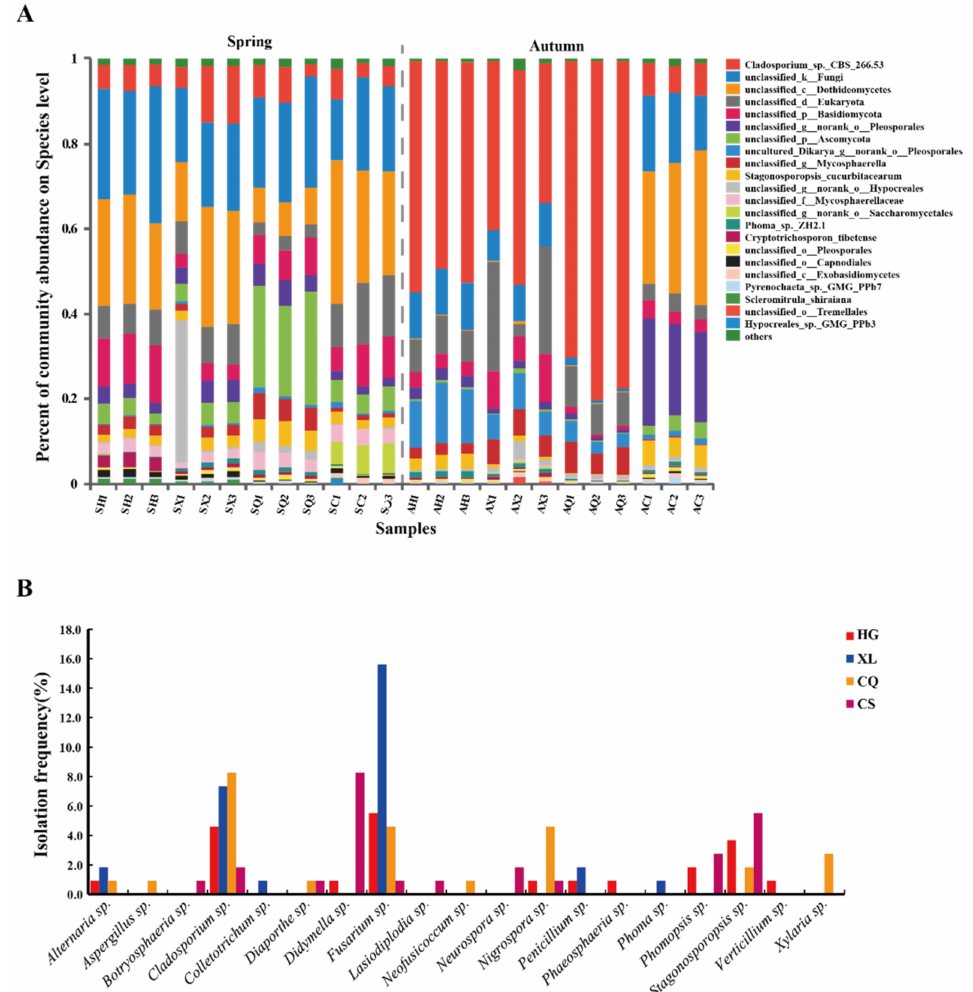
Figure 7. Taxonomic distribution and comparisons of diversity among the four mulberry cultivars ( A ) Distribution of taxa at the species-level based on ITS amplicons. n = 3 for each sample. Abbrevi- ations: SH, SX, SQ, and SC represent fungal communities from “Hong Guo No.2”, “Xin Lunjiao”, “Chuan Sang No.7637”, and “Changguo Sang” in spring, respectively. AH, AX, AQ, and AC represent fungal communities from “Hong Guo No.2”, “Xin Lunjiao”, “Chuan Sang No.7637”, and “Changguo Sang” in autumn, respectively. ( B ) Distribution of cultured-isolate taxa at the genus level from four mulberry cultivars. The isolation frequency (IF) was calculated using the formula: IF (%) = the number of isolates of a certain taxa/the total number of isolates × 100%. Abbreviations: CQ, CG, XL, and HG represent fungal communities from “Chuan Sang No.7637”, “Changguo Sang”, “Xin Lunjiao”, and “Hong Guo No.2”, respectively. Different colors represent different